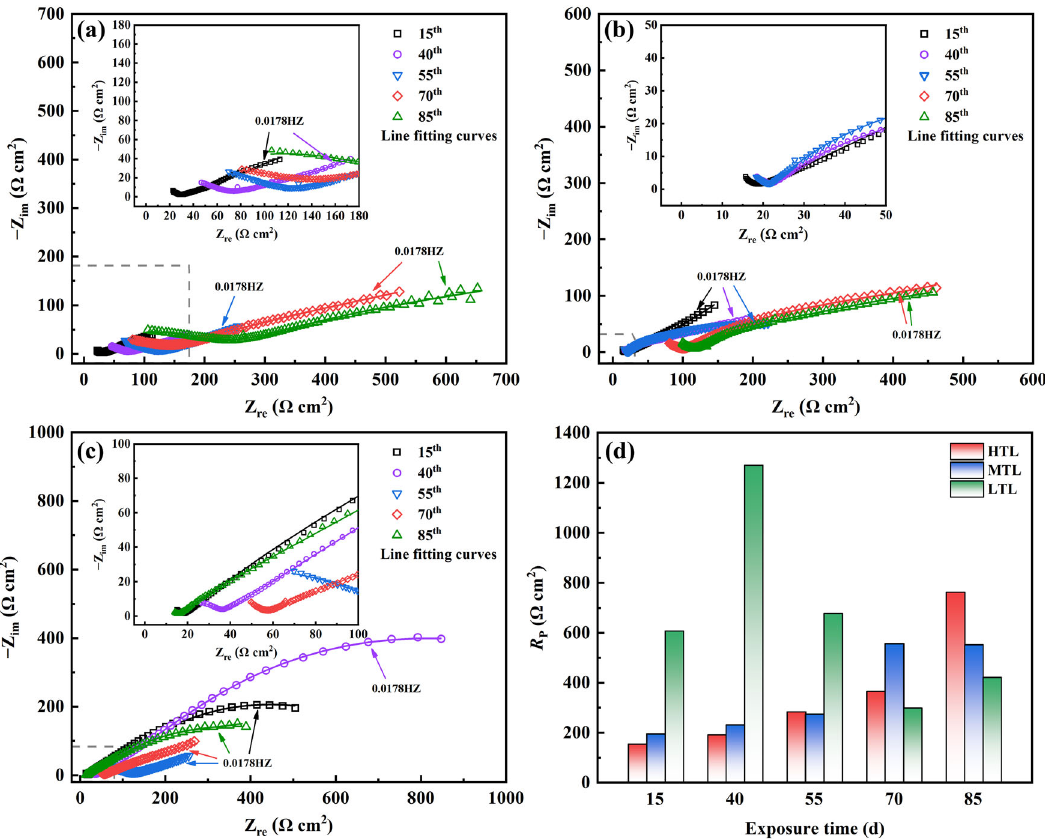
Fig. 5 EIS of the AISI 4135 steel samples after exposure to the tidal zone. Nyquist diagrams of the AISI 4135 steel samples after exposure to the a HTL, b MTL, c LTL for various periods and d calculated polarisation resistance results. The corresponding Bode diagrams can be found in Supplementary Fig. 2.